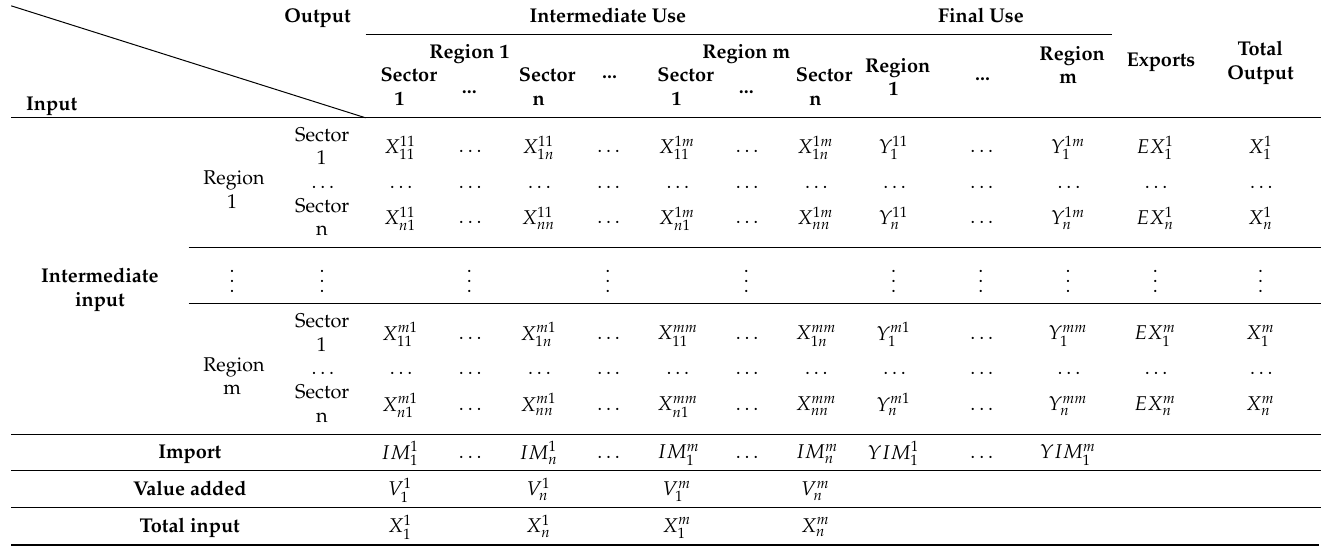
Table 1. The multi-regional input–output table short form. Source: the authors.